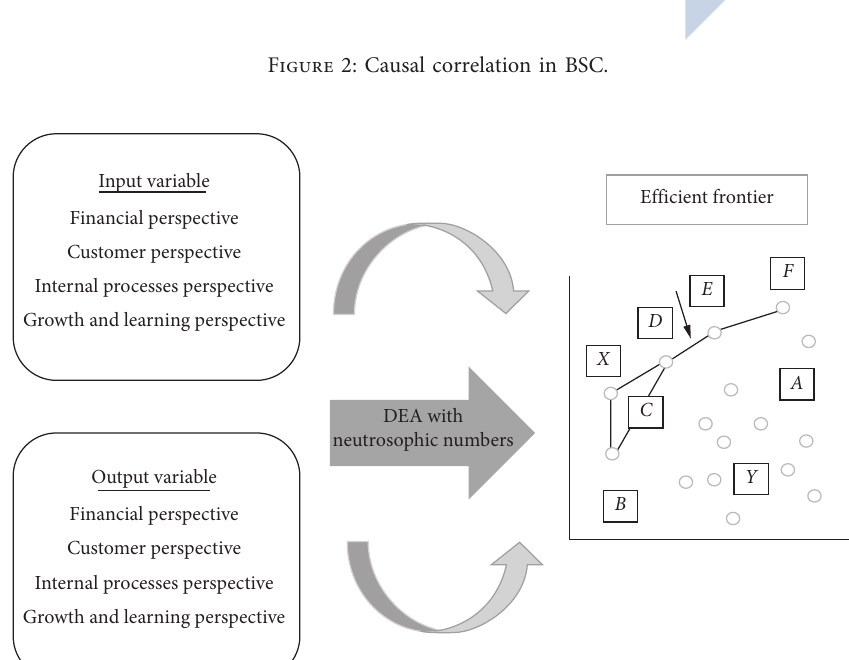
Figure 3: Hybrid BSC-DEA model with neutrosophic